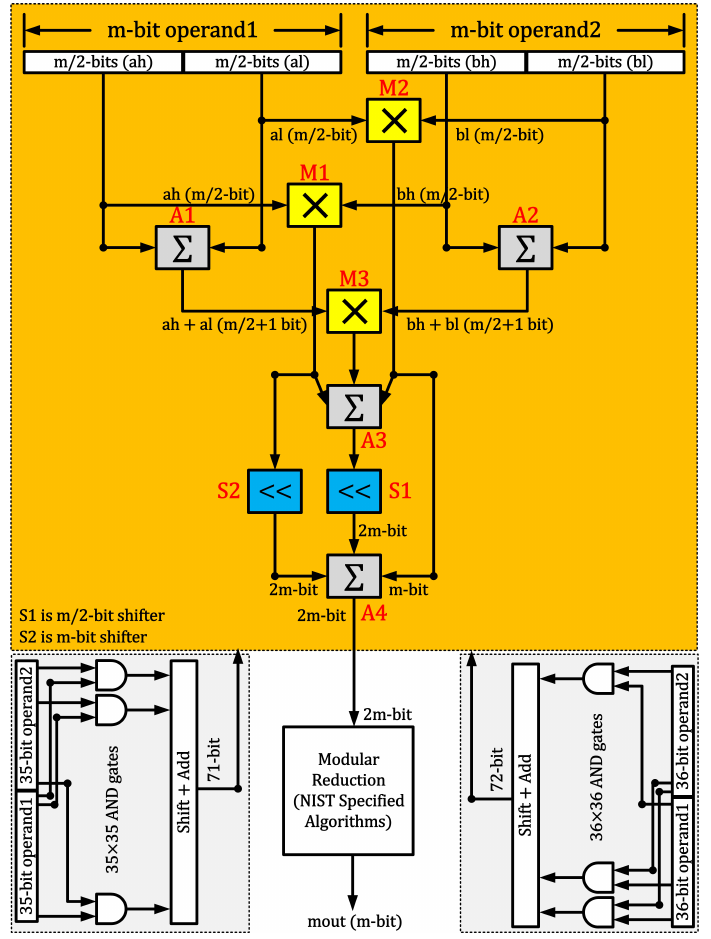
Figure 3. Proposed Karatsuba modular